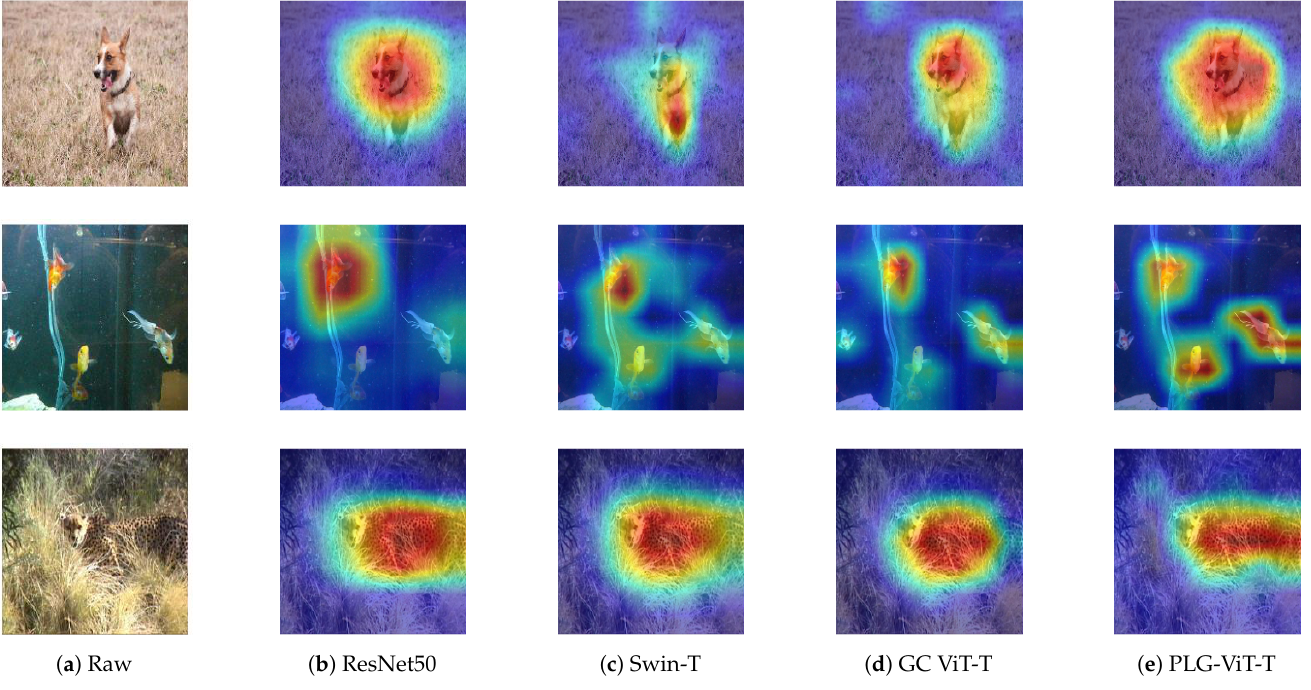
Figure 6. Visualization of the final activation with Grad-CAM [61]. ( a ): Input image; ( b – d ): SoTA [1,12,17]; ( e ) our